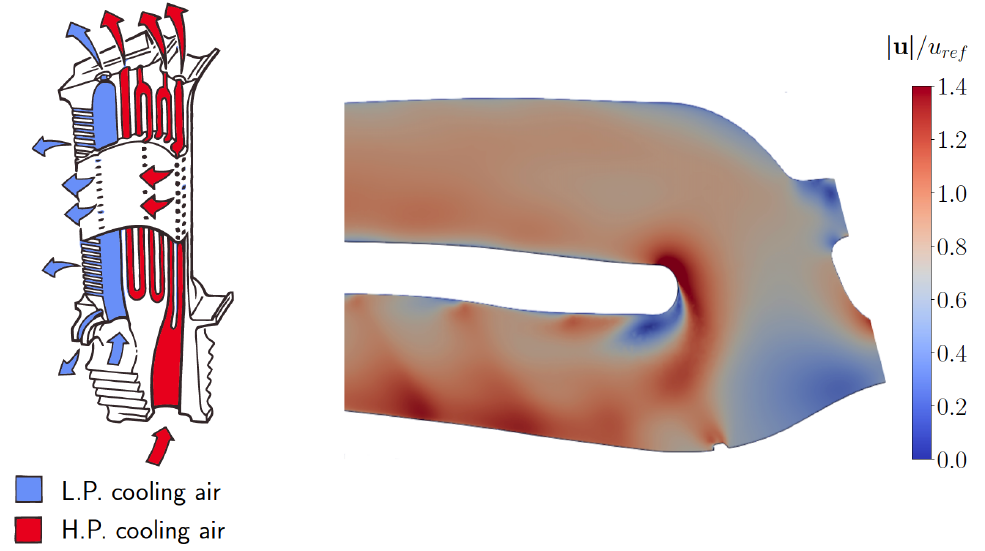
Figure 1. High pressure turbine cooling system ( left ) and CFD of internal passage ( right